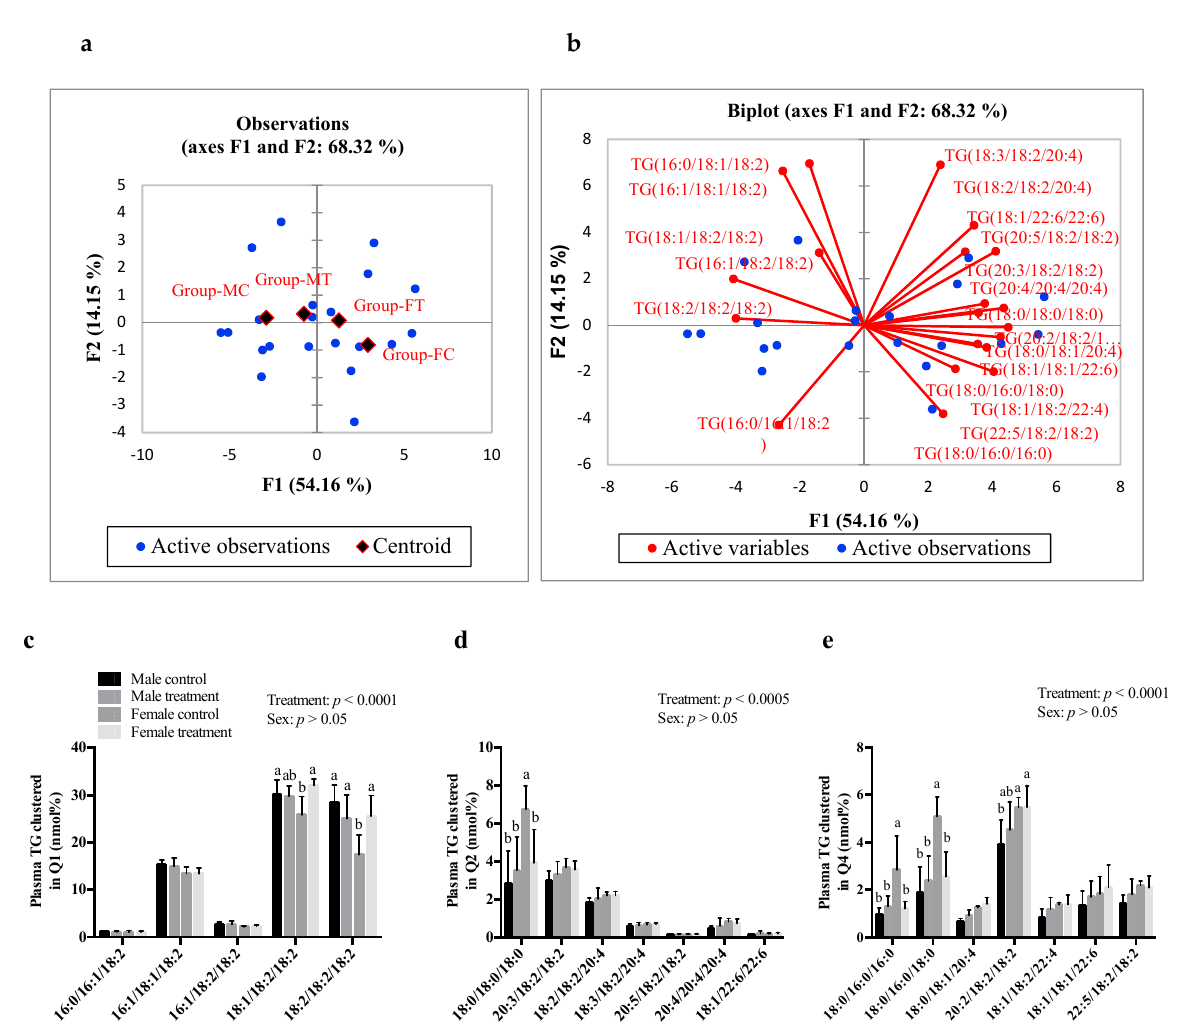
Figure 4. Intraperitoneal administration of SCFAs had a significant effect on plasma TG fatty acyl composition in females. Principal component analysis showing ( a ) observation plot and ( b ) biplot of TG molecular species clustered in: ( c ) Q1— quadrant 1, ( d ) Q2—quadrant 2, and ( e ) Q4—quadrant 4. Data were analyzed using multivariant analysis and two-way ANOVA followed by Tukey’s post hoc test. All data are expressed as mean ± SD. Different superscripts indicate significant difference amongst groups; p < 0.05 was considered significant ( n = 6). FC—female control, FT—female treatment, MC—male control, MT—male treatment, SCFAs—short-chain fatty acids, TG—triglycerides.